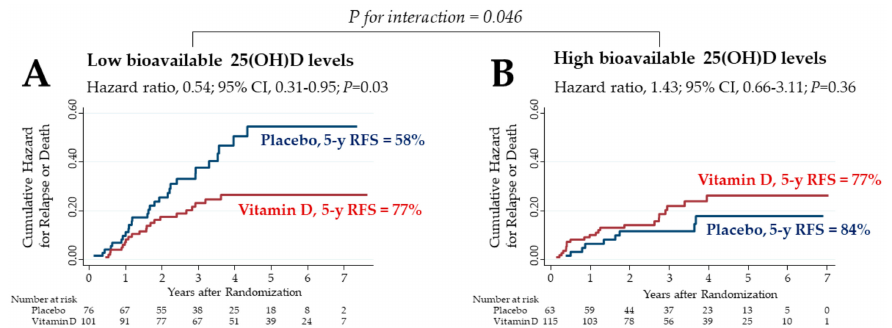
Figure 2. Nelson–Aalen cumulative hazard curves for relapse or death in the subgroups of bioavailable 25(OH)D levels lower ( A ) and higher ( B ) than median levels (1.71 ng / mL) before starting supplementation. 25(OH)D: 25-hydroxyvitamin D; CI: confidence interval; 5 y RFS: 5 year relapse-free